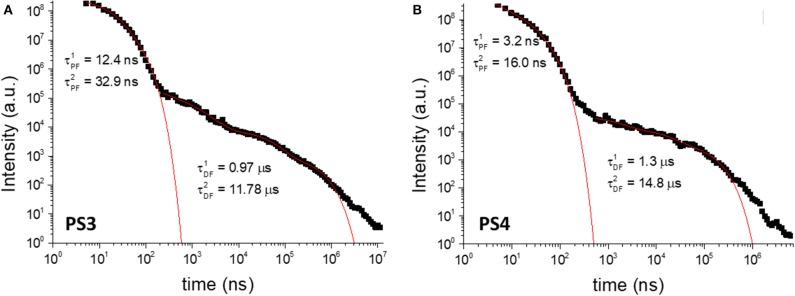
Luminescence decays of PS3 (A) and PS4 (B) collected in degassed aqueous suspension at room-temperature. λex = 355 nm.